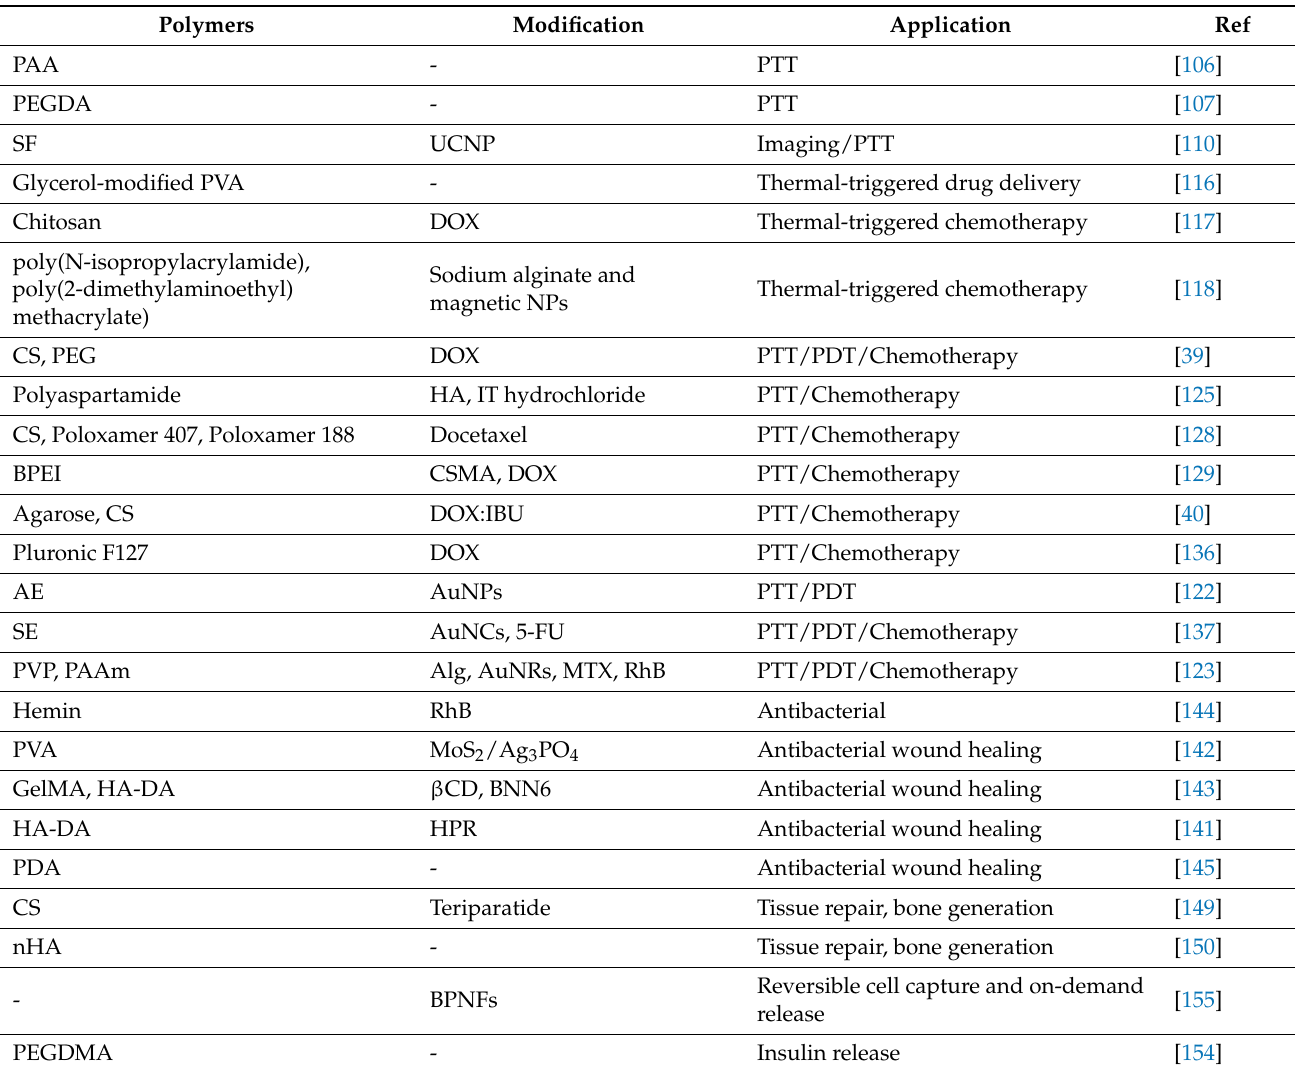
Table 2. Polymer component and modification of GGels for different applications of GGels in photothermal biomedicine.